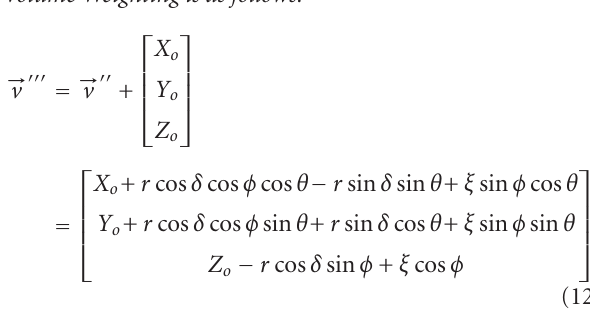
Table 14: Comparison of KWU with PARCS using mapped